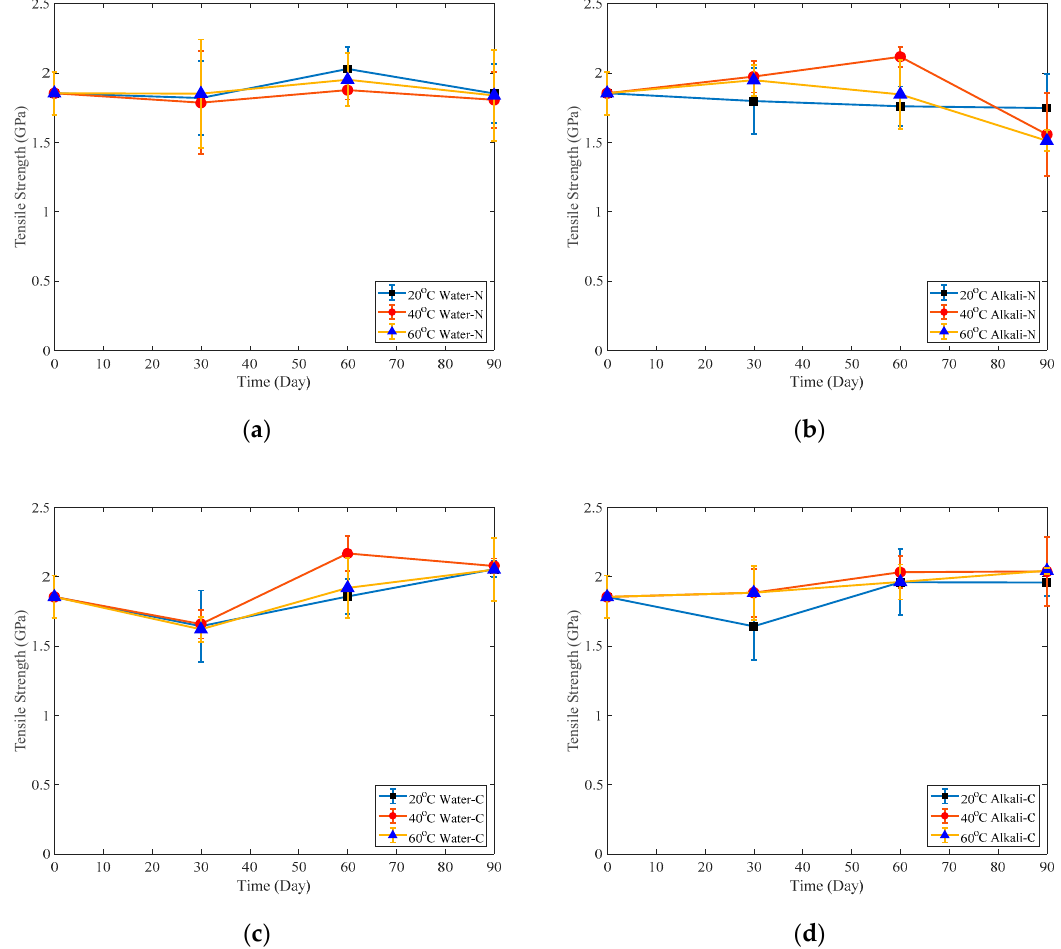
Figure 12. Tensile strength of: ( a ) Naked plate immersed in water; ( b ) Naked plate immersed in alkaline solution; ( c ) Coated plate immersed in water; ( d ) Coated plate immersed in alkaline solution.